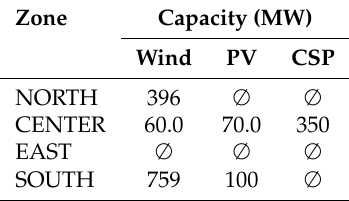
Table A2. Reference capacities per zone and technology installed in Morocco in 2018. Zone-technology pairs for which no capacity is installed are marked by an empty set ∅